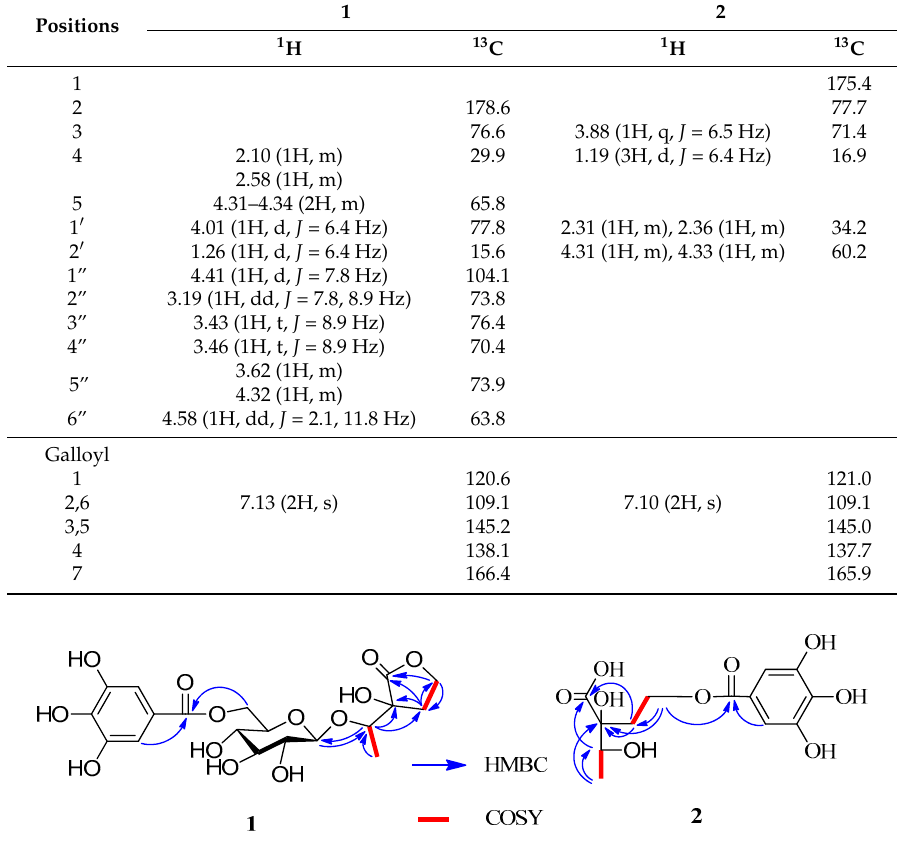
Figure 2. Key HMBC and 1 H- 1 H COSY correlations of 1 and 2 .